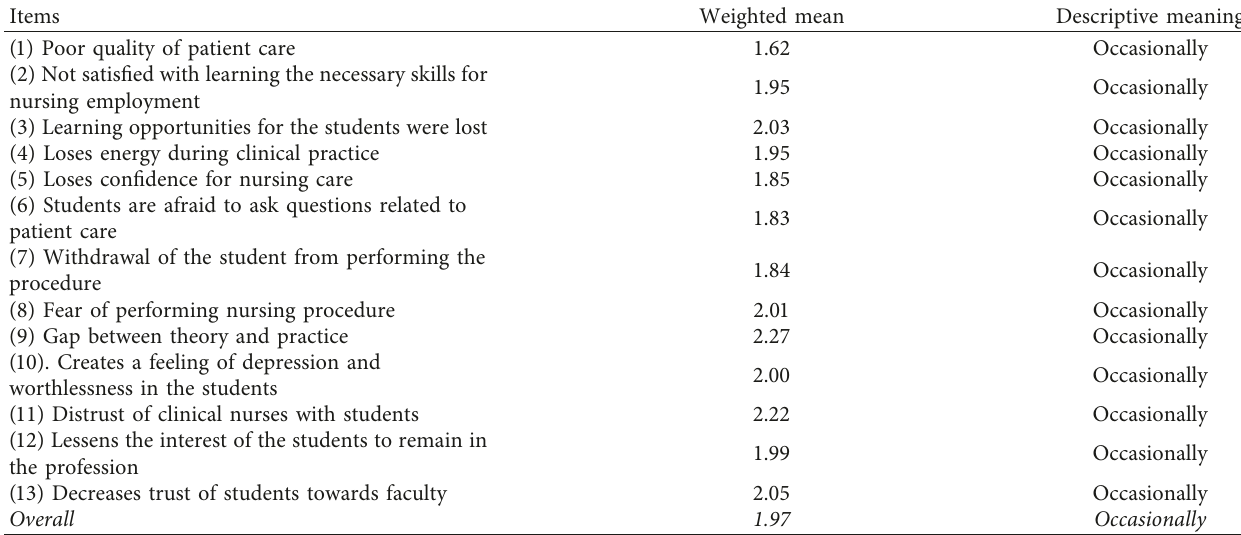
Table 3: Implications of clinical challenges towards learning outcomes.